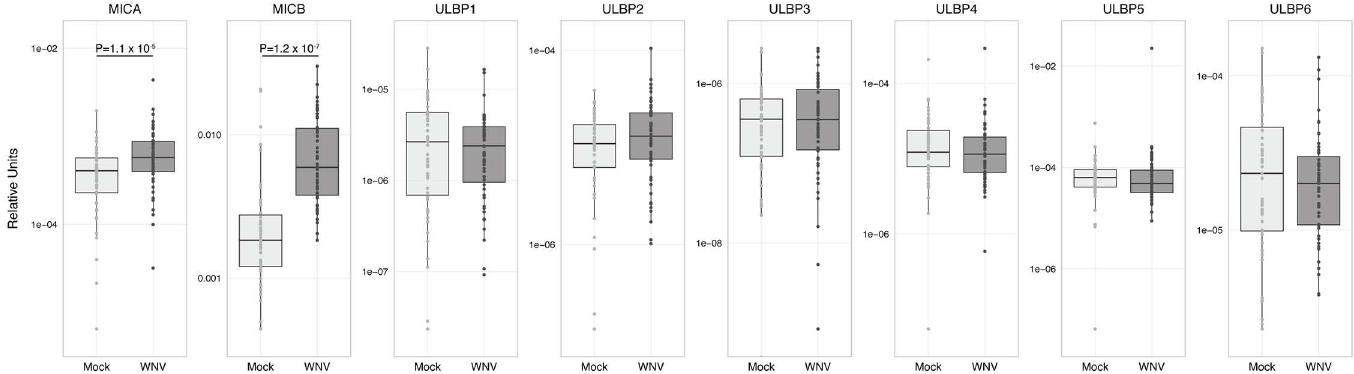
Fig 3. Expression levels of NKG2D ligands in PBMCs with infection of WNV in vitro . PBMCs were incubatedwith medium alone(mock) or infected with WNV (MOI = 1) for 24 h. Samples from all subjects (n = 56) were comparedby qPCR betweenmock and WNV-infected groups for expressionof MICA, MICB, ULBP1, ULBP2, ULBP3, ULBP4, ULBP5, and ULBP6, pairedWilcoxon